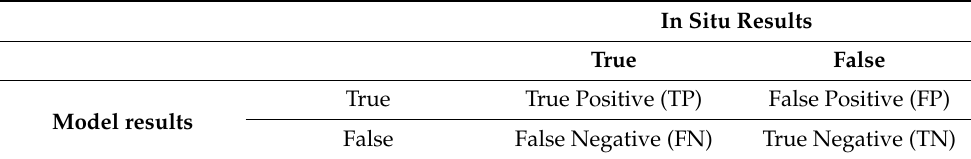
Table 2. Confusion